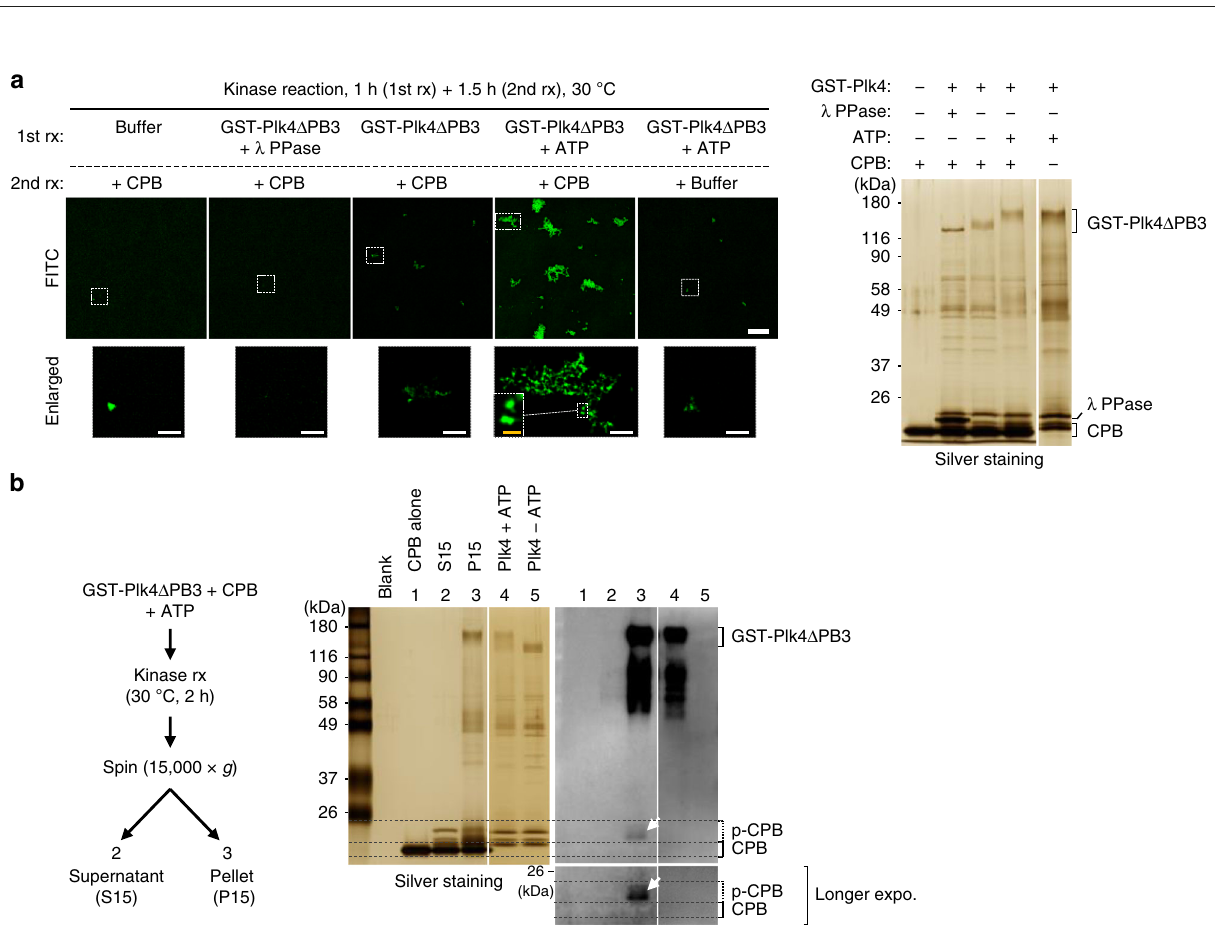
Fig. 6 Autophosphorylated CPB is suf fi cient to generate spherical condensates in a concentration-dependent manner. a Condensation pro fi les of CPB CP at various concentrations as measured by OD 350 nm at 20 °C. Different concentrations of soluble CPB CP were prepared at 4 °C. Upon shifting the temperature to 20 °C, optical density was measured every 3 s. Each point represents the average of two replicates± s.d. b 3D-SIM analysis showing the formation of spherical CPB condensates at various concentrations in vitro . Condensates formed at 20 °C were decorated with FITC for imaging (see Methods). Black bar, 2 μ m. Dotted boxes, areas of enlargement (bar, 1 μ m). A 3D surface-rendered spherical condensate (bar, 1 μ m) is shown at two different angles. The diameter and volume of spherical condensates were quanti fi ed (mean ± s.d., n = 200/each concentration from three independent experiments). Numbers denote mean values. c Condensation pro fi les of the indicated proteins (40 µ M) analyzed concurrently with a at 20 °C. Each point represents the average of two replicates ± s.d. Photographs showing the turbidity of each sample were taken after incubating 20 min or 3 days. d 3D-SIM images for the indicated proteins incubated at 4 °C (top) or 20 °C (bottom) for 1 h and decorated with FITC. Bar, 5 μ m. Dotted boxes denote areas of enlargement (bar, 1 μ m). DIC, Differential interference contrast. e DIC and 3D-SIM analyses for CPB CP condensates formed at 20 °C for 1 h in the presence of 5% 1,6-hexanediol and decorated with FITC. Bar, 20 μ m. f Live cell imaging of U2OS cells stably expressing EGFP-Plk4 CP before (0 s) or after 6% 1,6-hexanediol treatment for 10 s. Bar, 20 μ m. Quanti fi cation of relative fl uorescence intensities is shown in mean ± s.d. ( n = 101 for each timepoint from three independent experiments). g FRAP analysis for EGFP-Plk4 CP condensates in U2OS cells left untreated (left) or treated with 6% 1,6-hexanediol for 5 min (right). Images are from Supplementary Video 3. Bar, 2 μ m. Relative signal intensities were quanti fi ed from 16 independent condensates for each group. Bars, s.d. h FRAP was carried out after photobleaching the bottom half (dotted box) of an FITC-decorated CPB CP condensate formed in vitro. A representative time-lapse series is shown (left). Bar, 0.5 μ m. Relative signal intensities from 10 photobleached experimental hemispheres and their